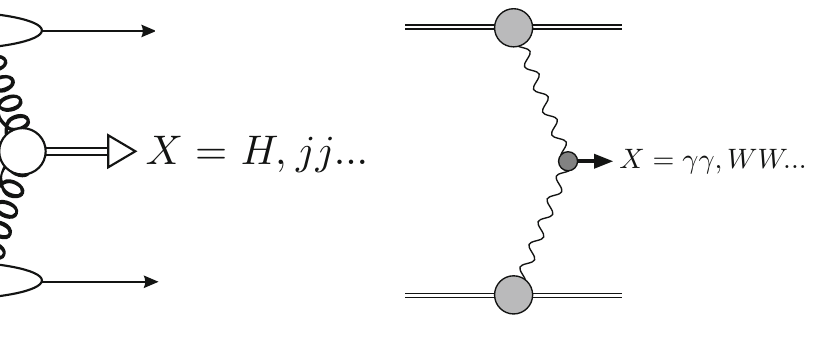
Fig. 1 Schematic diagrams for (left) QCD and (right) photon initiated